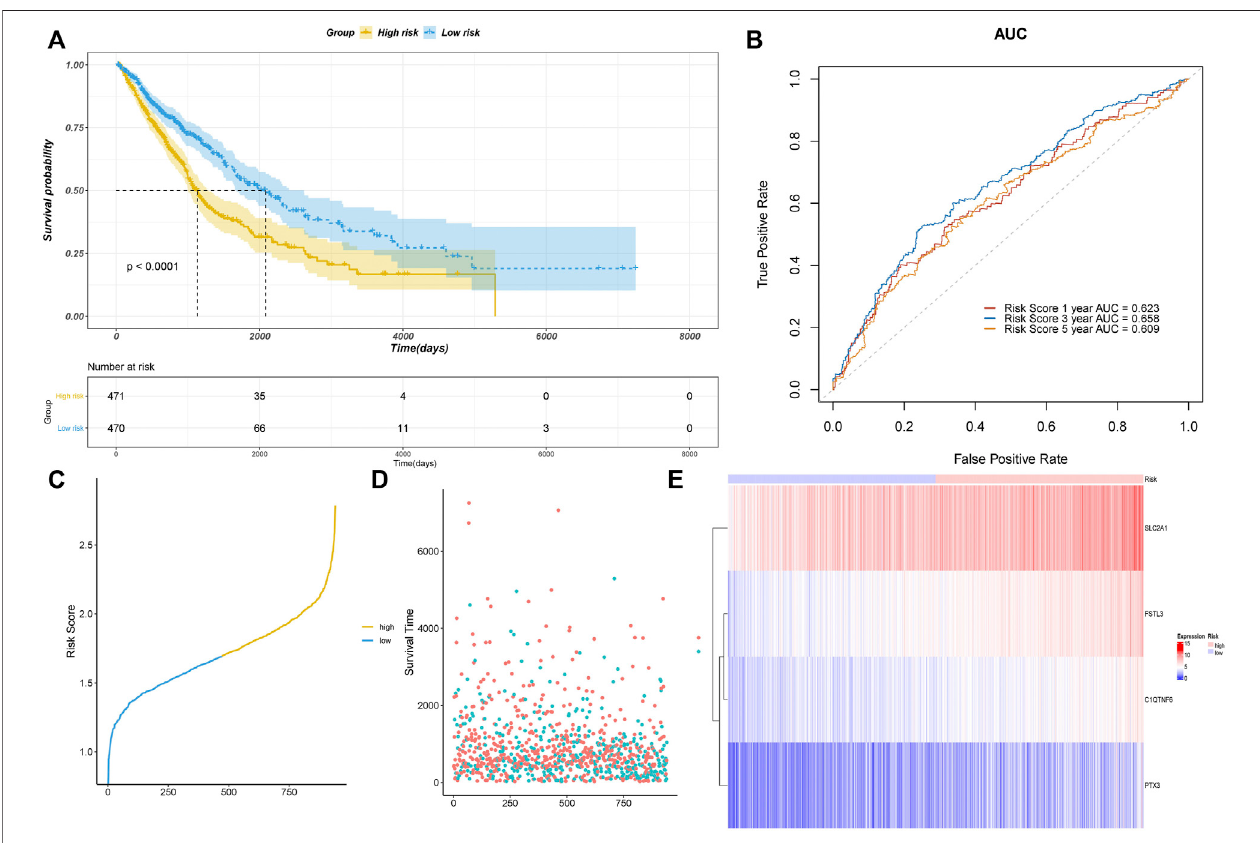
FIGURE 4 | Assessment of the risk model based on TCGA data. (A) Kaplan – Meier curve validation. (B) ROC curve validation. (C) Risk score of all samples. (D) Scatter plot of the survival time of all samples. (E) Heatmap of the prognostic genes in high- and low-risk